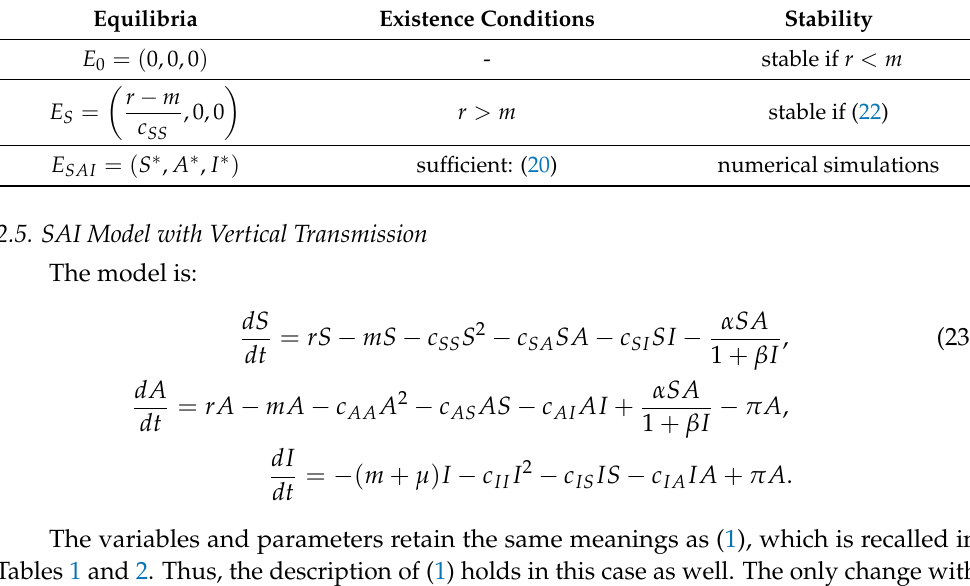
Table 3. Summary of equilibria and local stability for model (1). Equilibria Existence Conditions Stability